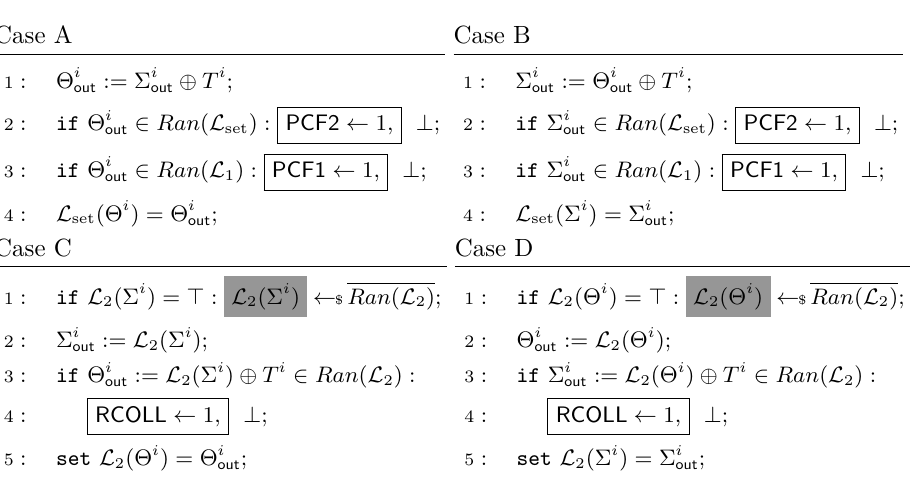
Figure 5.2: Continutation of ideal oracle $: PCF1 and PCF2 is defined in Case A and Case B. RCOLL is defined in Case C and Case D. We denote the bad event defined in Case C and Case D by RCOLL 1 and RCOLL 2 respectively. ⊥ and > denotes the abort symbol and an undefined variable resp. Shaded box represents uniform sampling in ideal